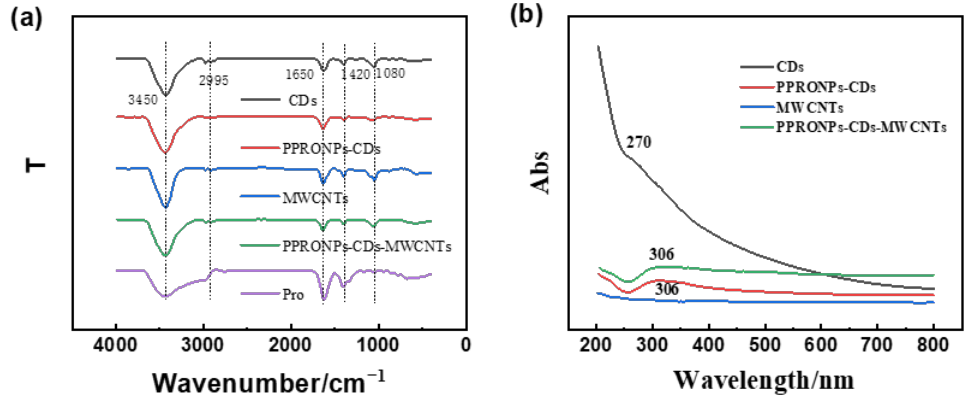
Figure 3. FT-IR spectra ( a ) of Pro, CDs, PPRONPs − CDs, MWCNTs, and PPRONPs − CDs − MWCNTs. UV – vis spectra ( b ) of CDs, PPRONPs − CDs, MWCNTs, and PPRONPs − CDs − MWCNTs. UV–vis spectra ( b ) of CDs, PPRONPs–CDs, MWCNTs, and